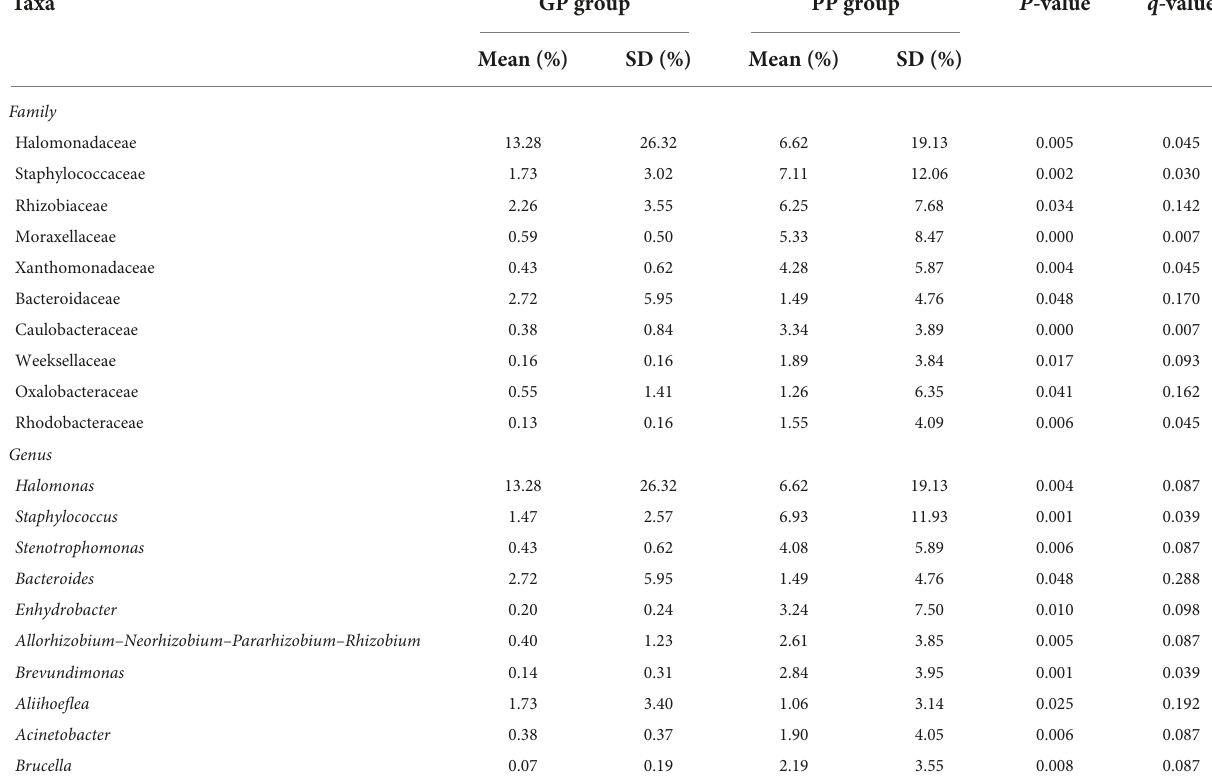
TABLE 3 Differences of relative abundance in the skin microbiota between GP and PP groups.